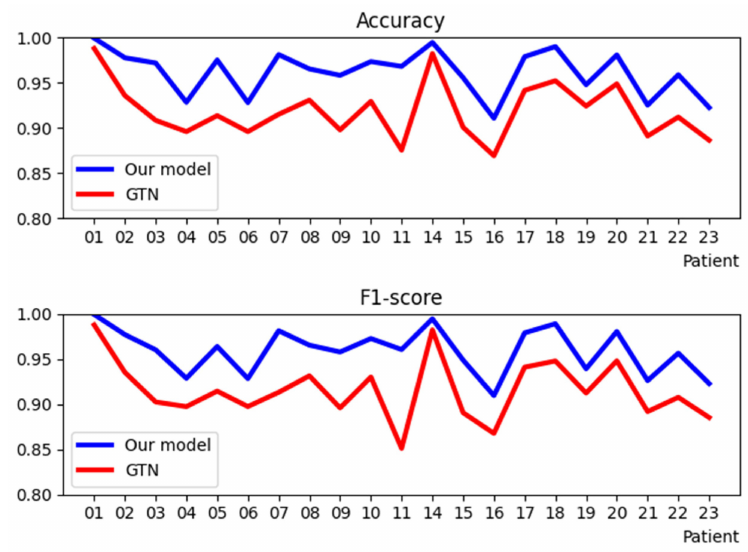
Figure 6. The accuracy and the F 1 score of the GTN and our model for 21 patients. The classification results were subsequently post-processed to obtain the prediction results from our seizure prediction model. The FPR classified for our network alone and after post-processing is shown in Table 4. It can be seen that after post-processing, our FPR decreased, on average, from 0.19/h to 0.047/h. This effectively eliminated sporadic errors from the process of model classification and improved the performance of our epileptic seizure prediction system so as to better complete the prediction task. Table 4. The comparison between the performance of the GTN and our model. Without Post-Processing Patient No. of Seizures